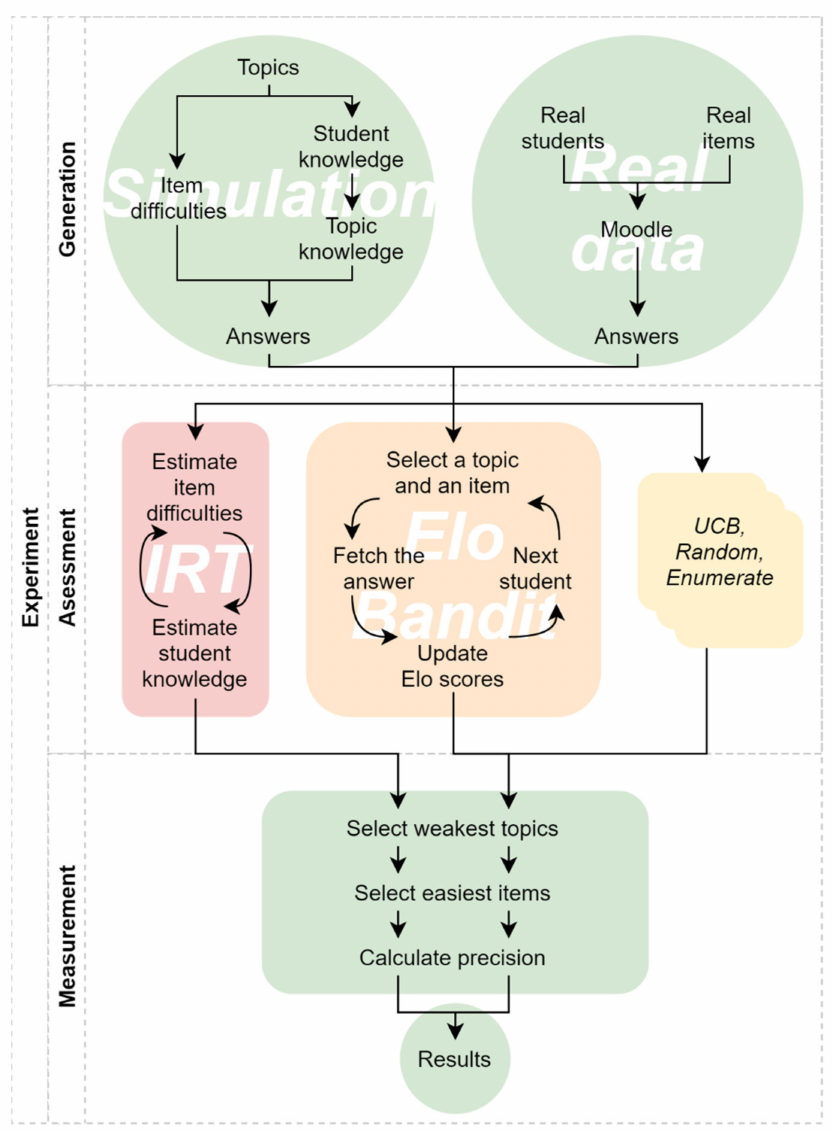
Figure 1. Schematic representation of research methodology and its principal